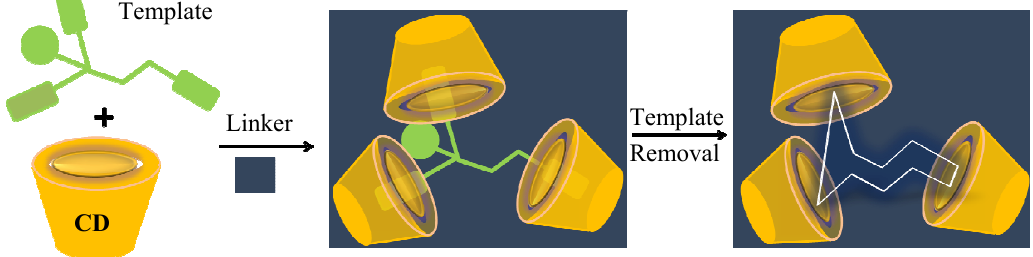
Figure 6. Schematic showing mechanism of CD-MIPs preparation using bulk imprinting technology (redrawn from